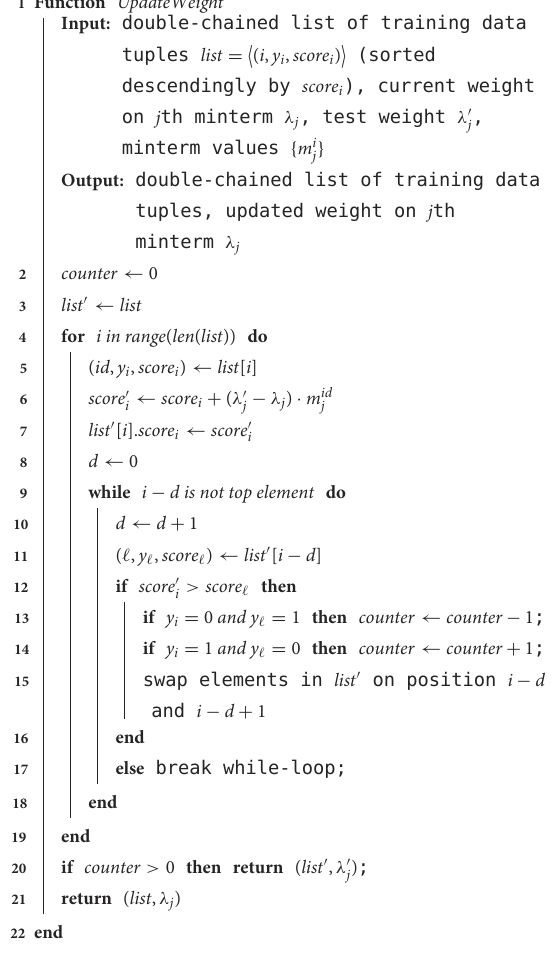
1 Function UpdateWeight Input: double-chained list of training data